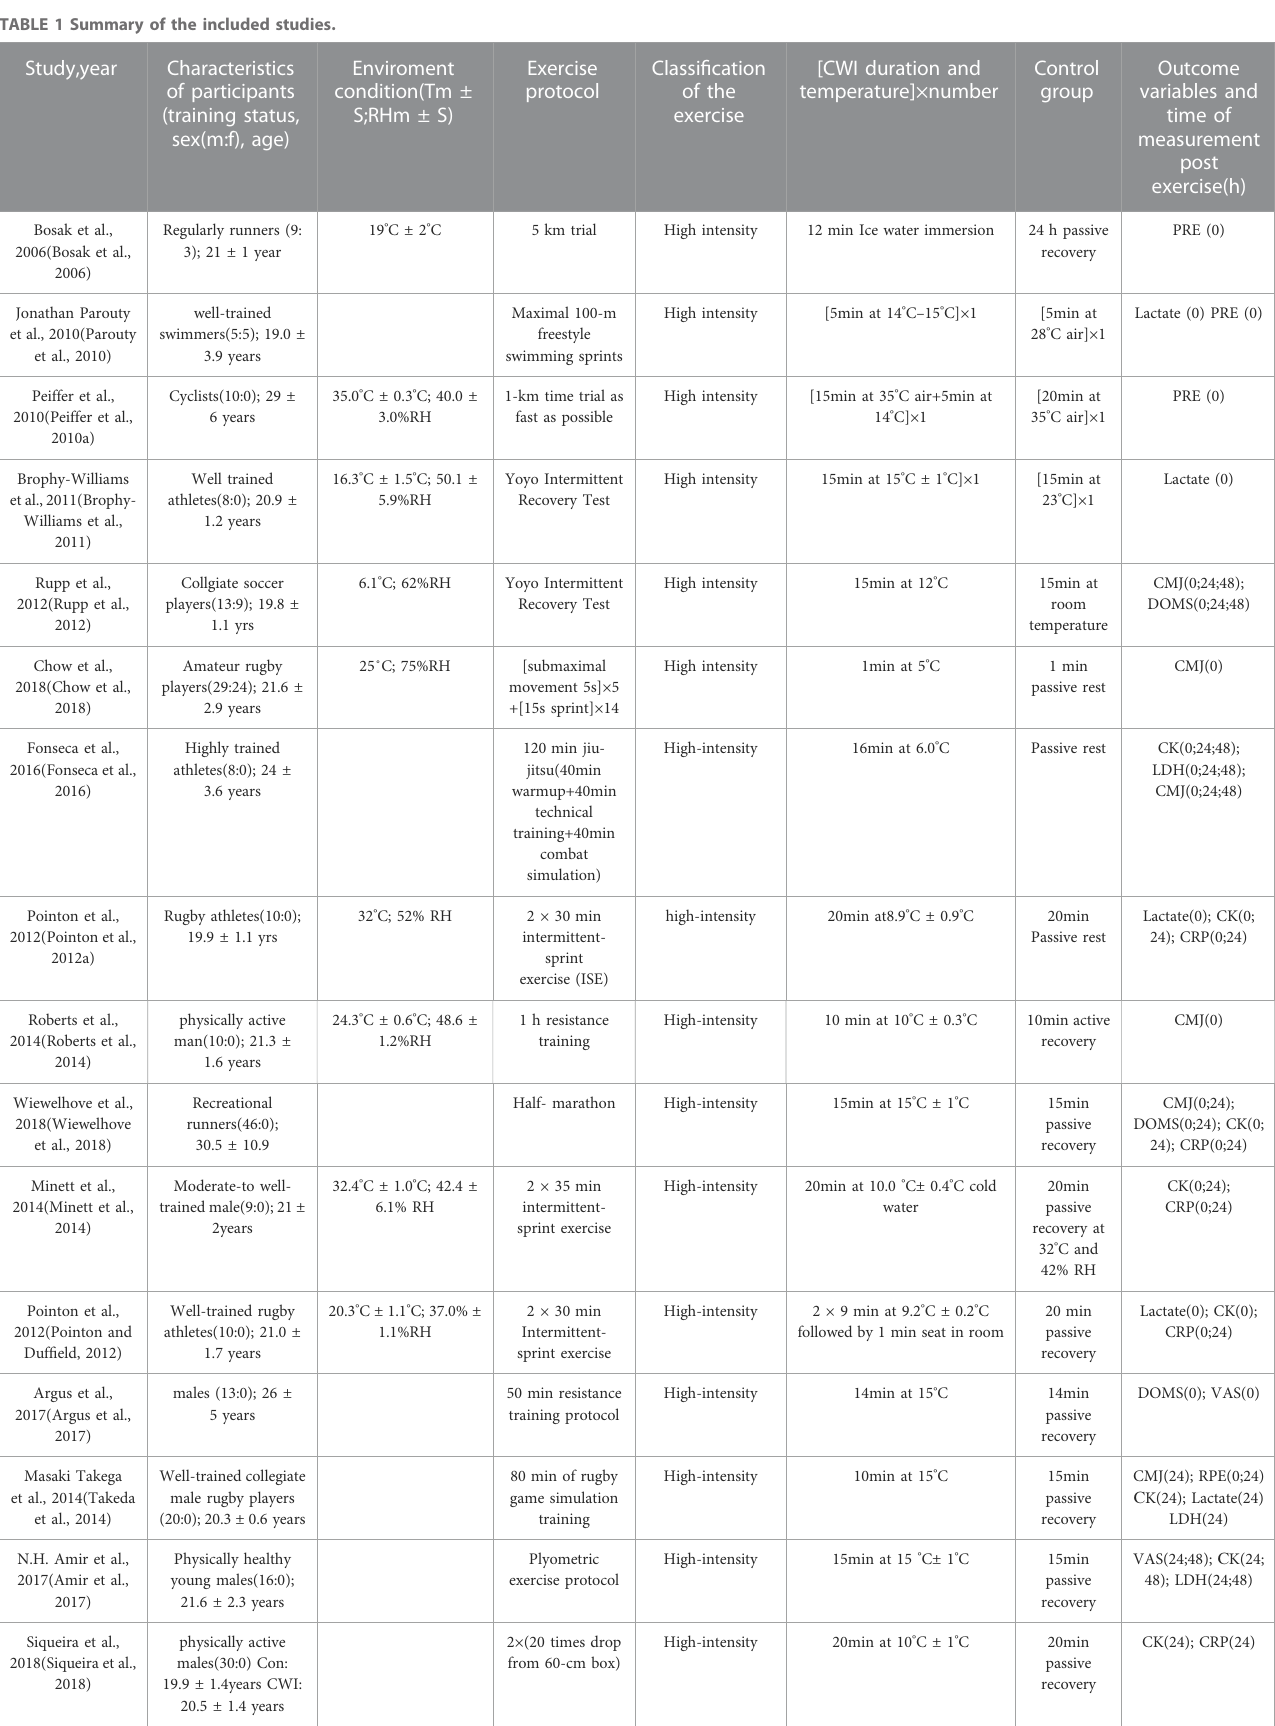
TABLE 1 Summary of the included